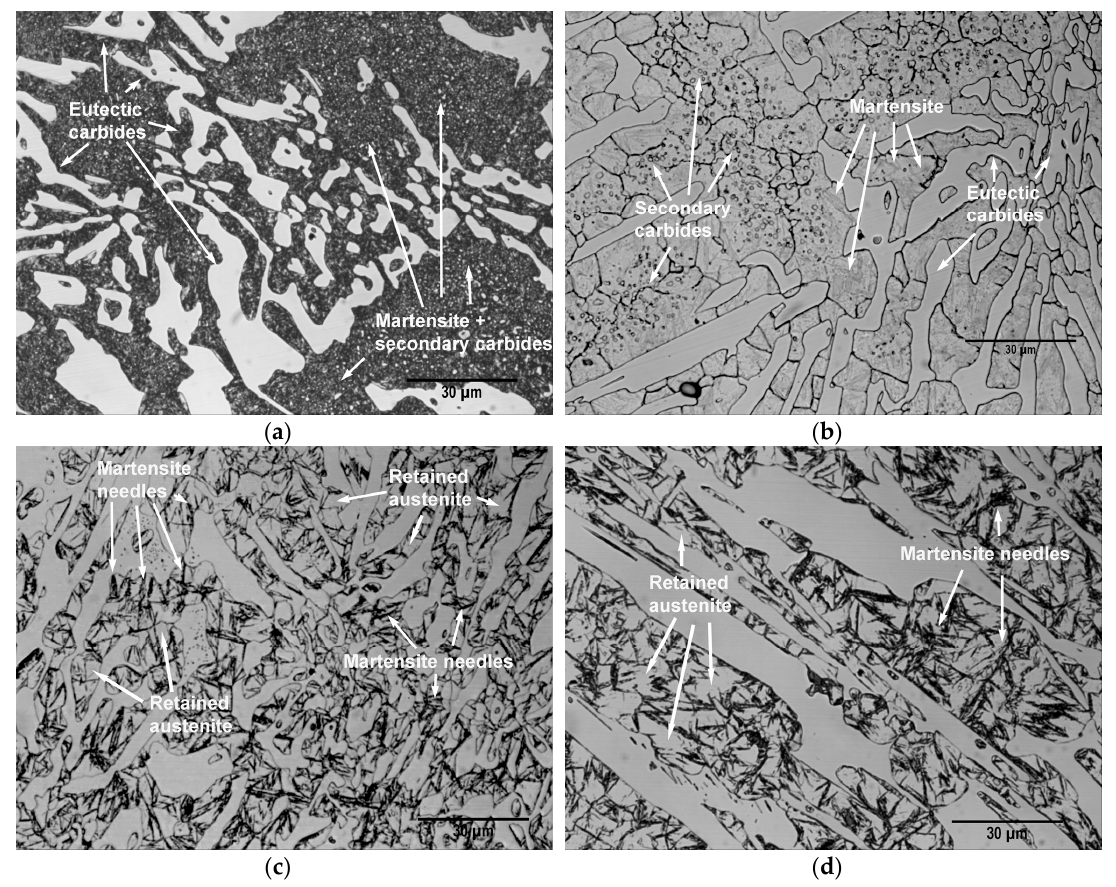
Figure 6. Representative micrographs of the microstructure obtained after the different heat treatments (all at ×1000 magnification): ( a ) Experiment 1; ( b ) Experiment 2; ( c ) Experiment 6; ( d ) Experiment 8.